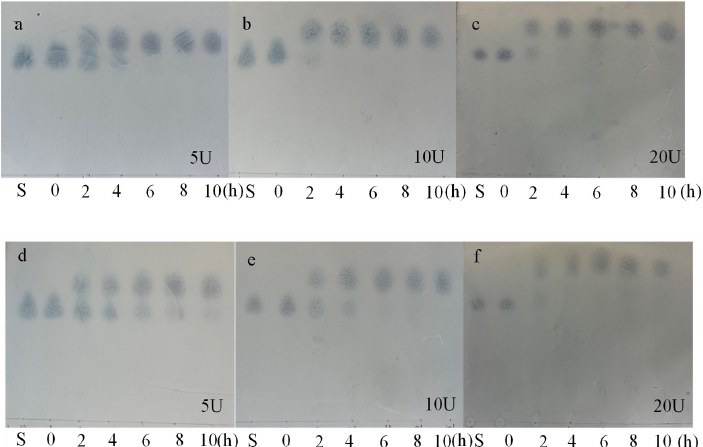
Figure 5. The TLC analysis of hydrolysates of melibiose and raffinose by purified α -galactosidase. ( a , d ) Enzyme dosage was 5 U/mL; ( b , e ) enzyme dosage was 10 U/mL; ( c , f ) enzyme dosage was 20 U/mL.